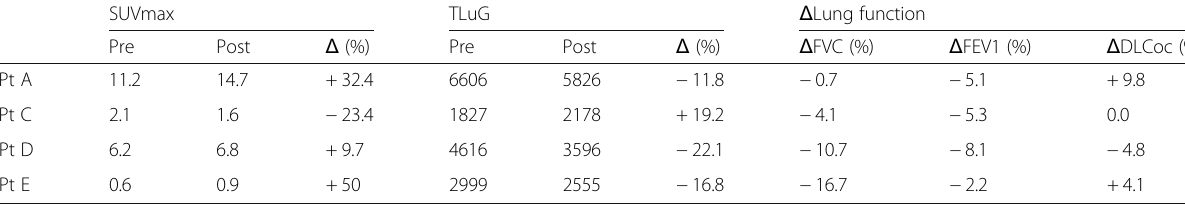
Table 5 Discordant response in SUVmax and TLuG in four patients SUVmax TLuG Δ Lung function Pre Pre